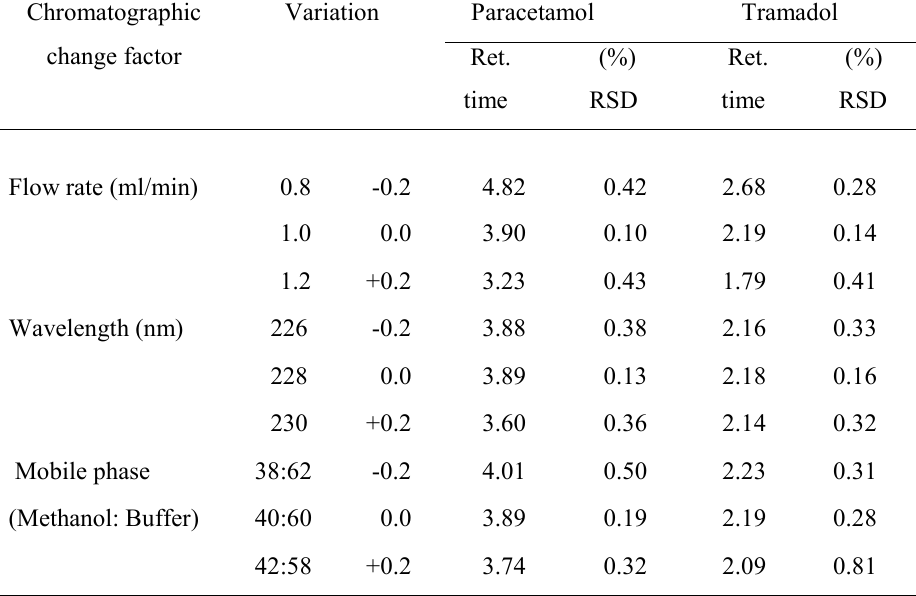
Table 3. Results from robustness